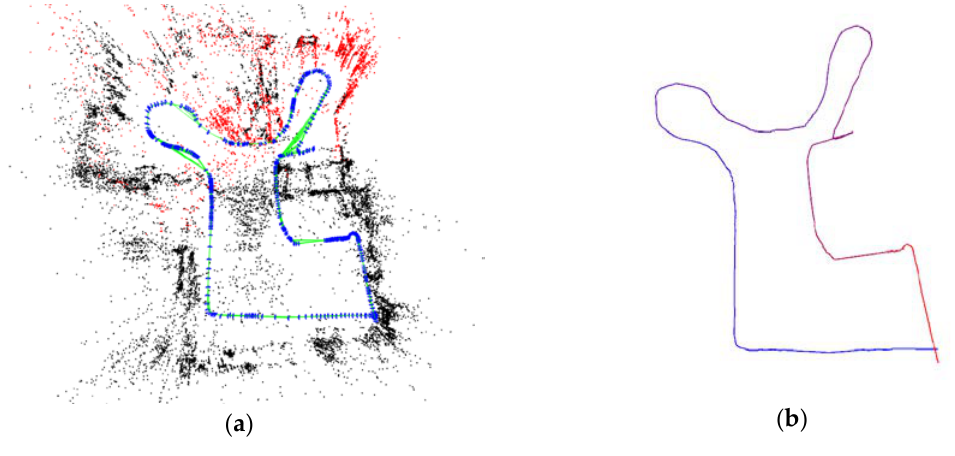
Figure 8. Visualization of the offline map and mapping trajectory. ( a ) Point-cloud map; ( b ) mapping